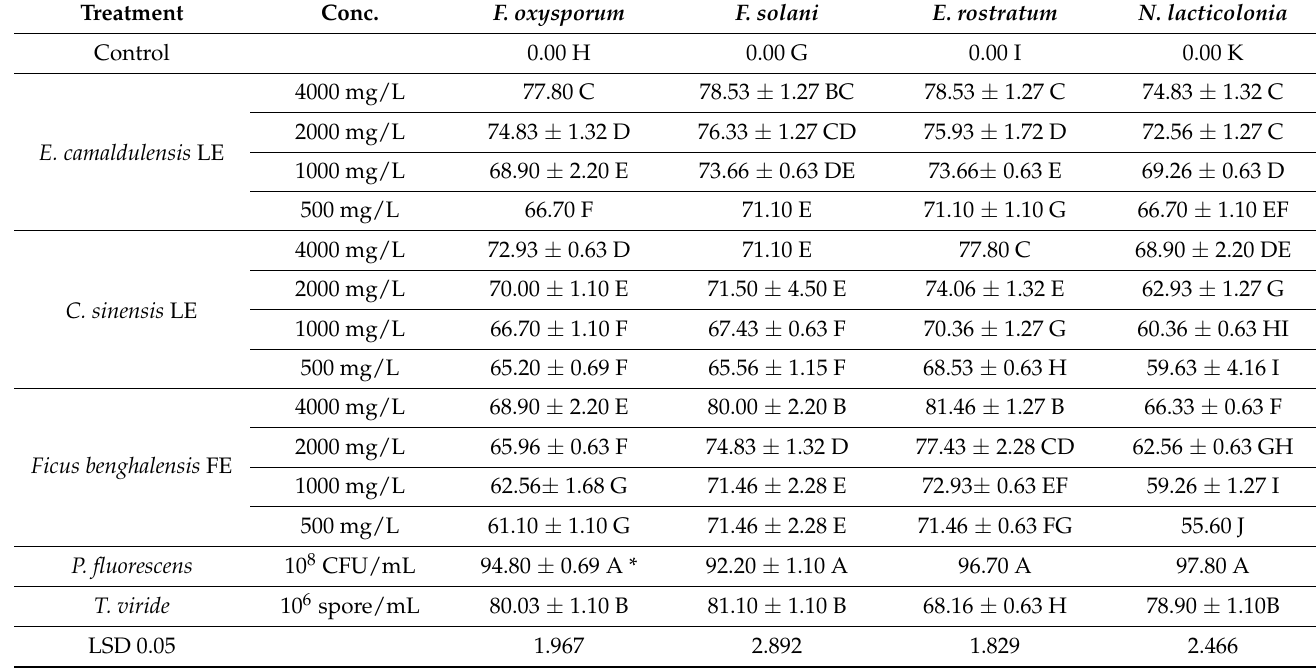
Table 2. Antifungal activity of P. fluorescens and T. viride bioagents and E. camaldulensis LE, C. sinensis LE, and F. benghalensis FE on F. oxysporum , F. solani , N. lacticolonia , and E. rostratum isolates under in vitro condition. Treatment Conc.